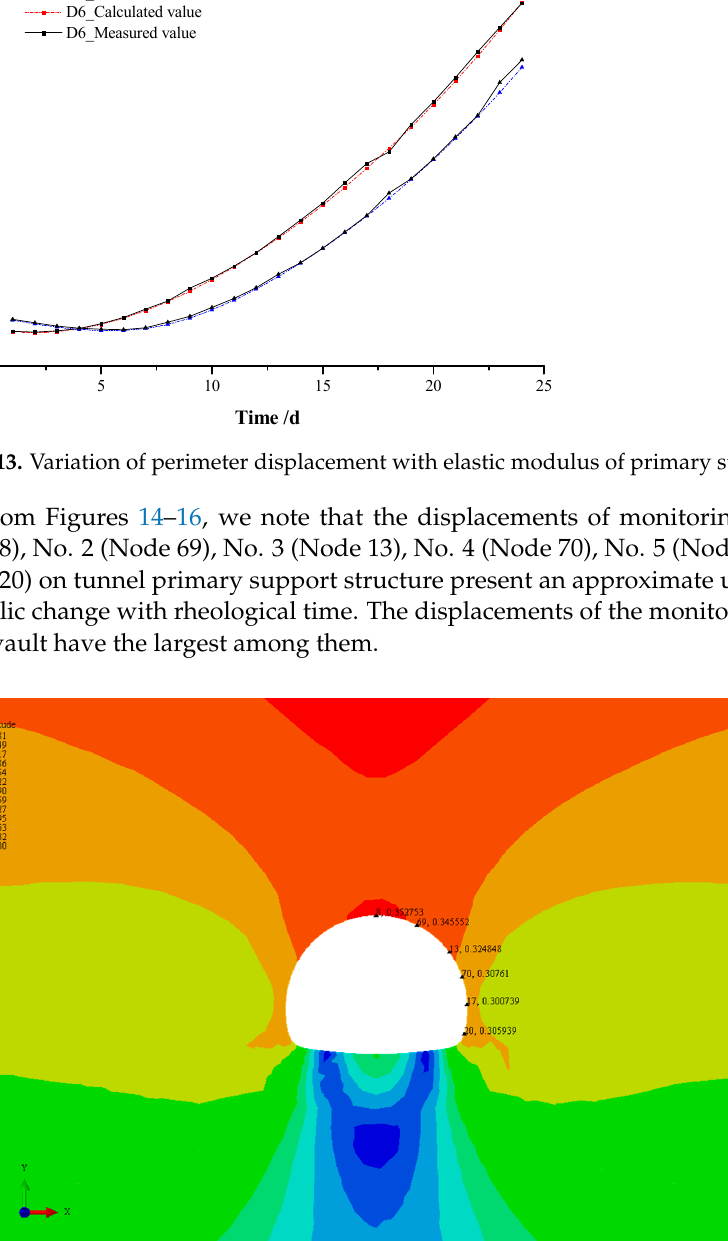
Figure 15. Contour map of tunnel displacement at rheological time 837 h. (4) The average displacement rate at the fourth stage is very much larger than that at the third stage. For example, the average displacement rate of monitoring point NO.1 at the fourth stage is 2.336 cm/d from 542.5 h to 800 h of rheology time. (5) The average displacement rate at the fifth stage is very much larger than that at the fourth stage. For example, the average displacement rate of monitoring point NO.1 at the fifth stage is 3.695 cm/d from 800 h to 850 h of rheology time.